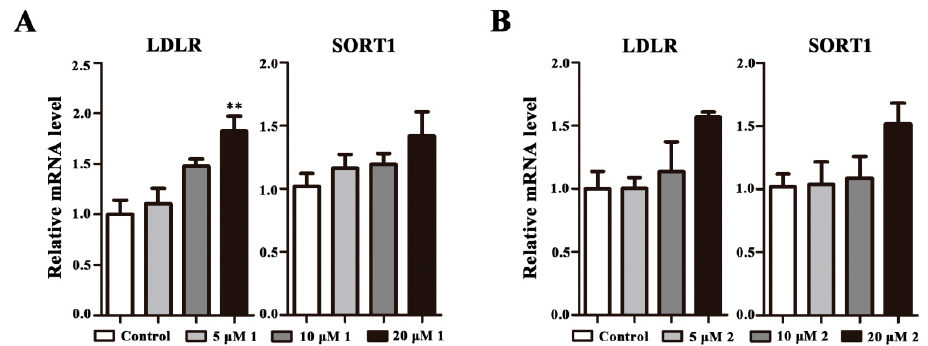
Figure 5. 1 or 2 stimulates the expression of LDLR and SORT1 genes. HepG2 cells were treated with 1 or 2 at 5, 10, and 20 µ M for 48 h. Target mRNA levels are expressed relative to those in control by qPCR method. All data are expressed as mean ± SEM ( n = 3), and analyzed by ANOVA with Bonferroni’s test. ** p < 0.01 vs control.